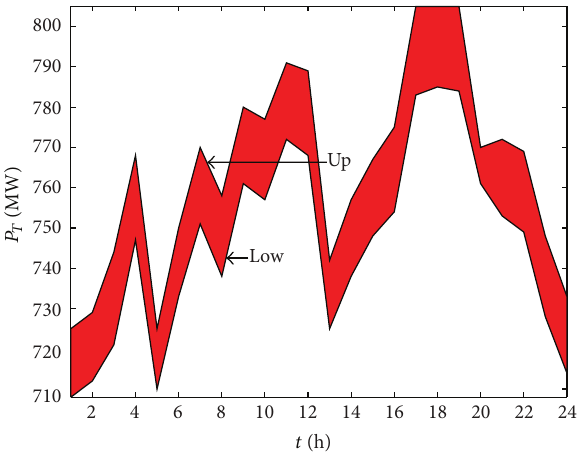
Figure 7: The optimal output range of thermal power plant